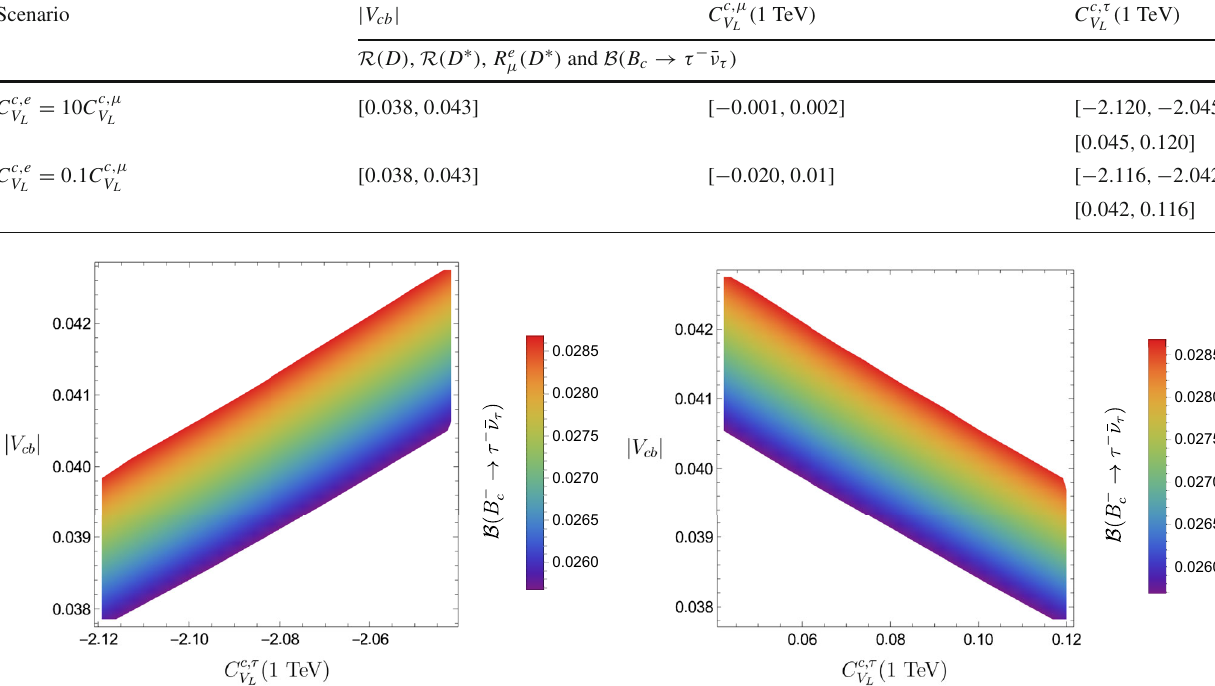
Table 12 Values of | V cb | in different NP scenarios correlating C c , e are not bounded regions